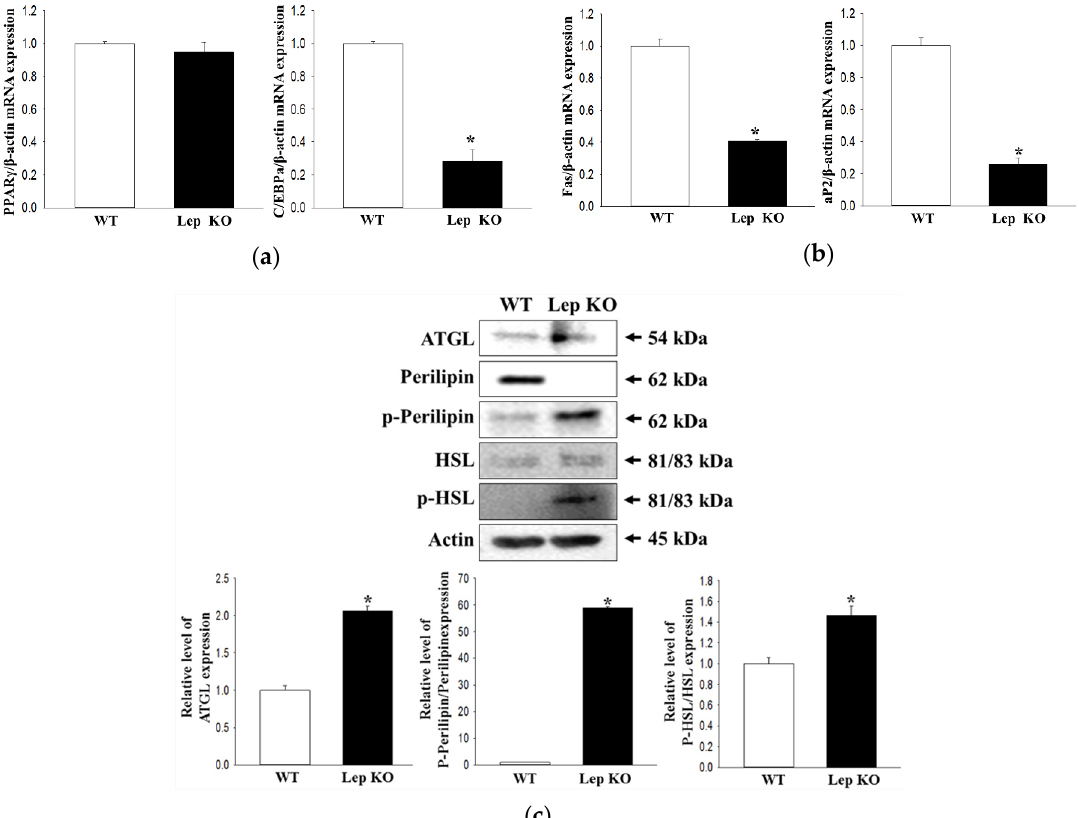
Figure 9. Expression of the lipogenesis and lipolysis associated genes. After purification of the total RNA from the transverse colon, RT-qPCR using the specific primers was performed to analyze the expression levels of the genes associated with adipogenesis (C / EBP α and PPAR γ ) ( a ) and lipogenesis (Fas and aP2) ( b ). Three to five mice per group were used to prepare total RNA, and RT-PCR were assayed in duplicate for each sample. ( c ) Western blot analysis was performed to detect the phosphorylation or expression of several lipolysis-associated proteins, including perilipin, p-perilipin, HSL, p-HSL, and ATGL. The intensity of each band was determined using an imaging densitometer, and the relative levels of the four proteins were calculated based on the intensity of β -actin. Three to five mice per group were used to prepare the liver tissue homogenate, and Western blot analyses were assayed in duplicate for each sample. The data are reported as the mean ± SD. *, p < 0.05 compared to the WT group. Abbreviations: WT, Wild type; KO, Knockout type; RT-qPCR,